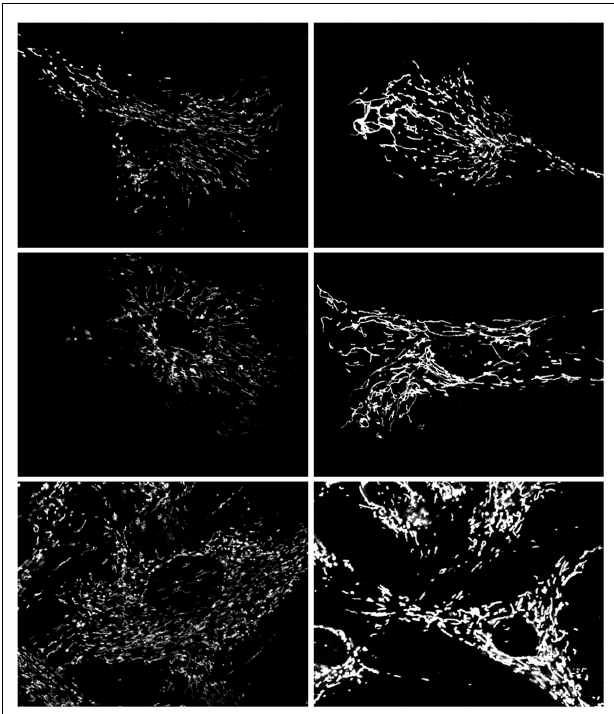
FIGURE 6 | Effects of treatment with 2mM 3-AT on mitochondrial ROS staining. Control Hs27 cells (left column) demonstrate less mitochondrial ROS staining than 3-AT treated cells (right column) after 24h (top row), 48h (middle row), and 5days (bottom row). In addition, staining in 3-AT treated cells appeared homogeneous throughout the mitochondria. Live cells were imaged under identical conditions, and are representative of numerous fields viewed and